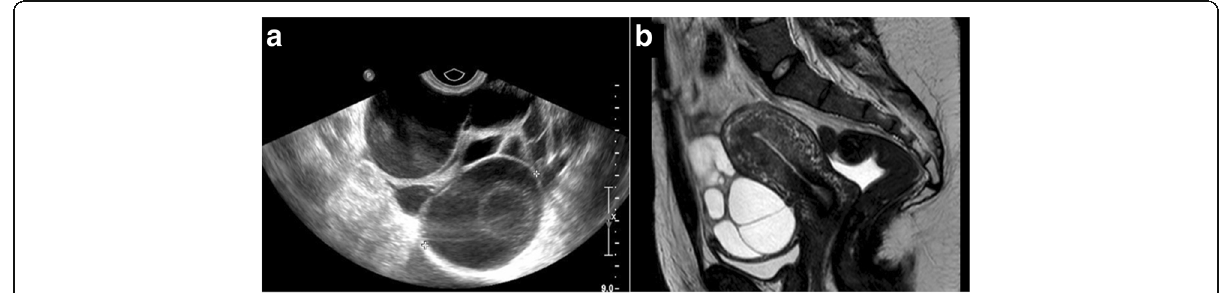
Fig. 1 Multiple ovarian cysts revealed in pelvic ultrasonogaphy and MRI. Pelvic ultrasonography ( a ) revealed an enlarged 7x5 cm left ovary containing multiple cysts without fluid in the pelvis. This sagittal pelvic Magnetic Resonance Imaging ( b ) T2 weighted images showed a left multicystic